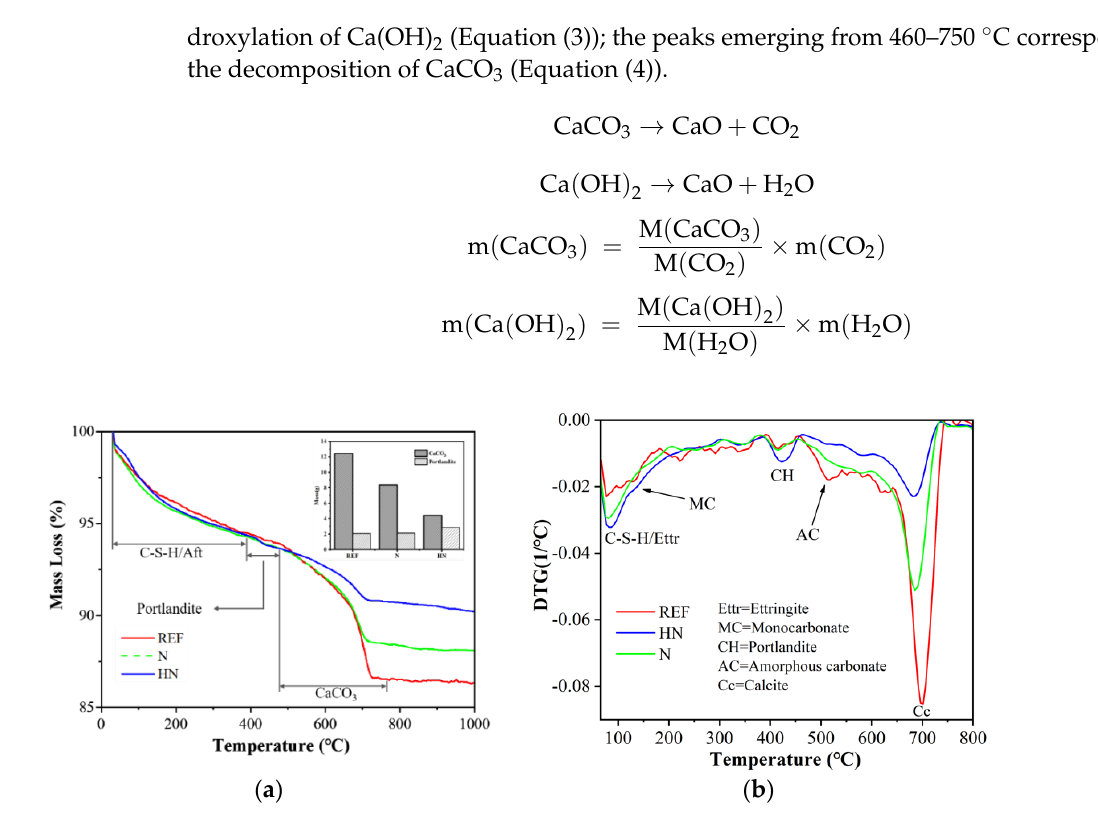
Table 6. Content of CaCO 3 and Ca(OH) 2 in different samples after